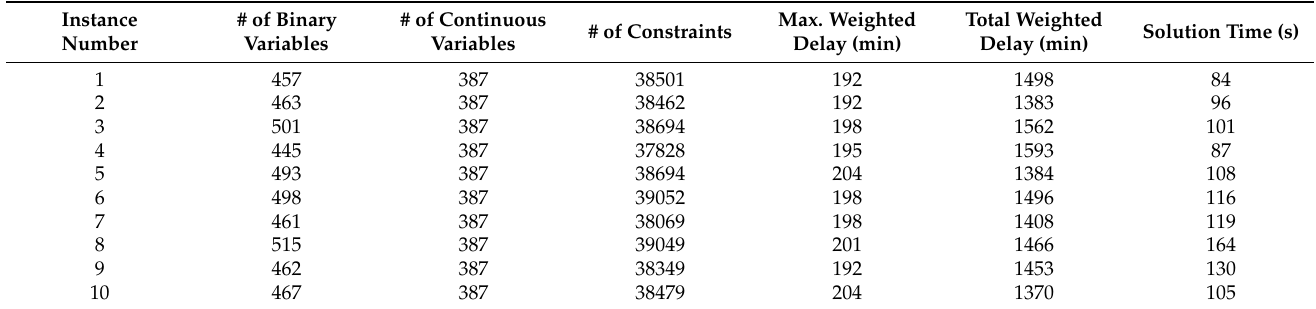
Table 14. Summary of all the final solutions of every instance.